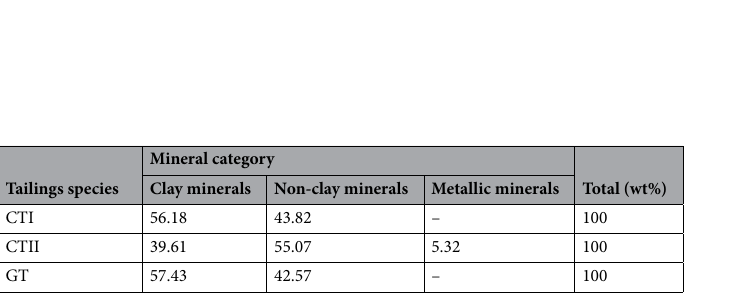
Table 3. Mineral contents of the three types of tailings according to mineral